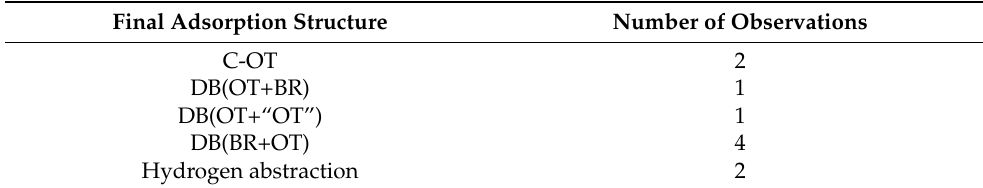
Table 3. Final configuration of ECCO in the 10 AIMD runs. The intermediate step to a DB(OT+OT) structure is labeled DB(OT+“OT”). Hydrogen abstraction indicates a structure in which hydrogen in the α position to the cyclooctyne triple bond was transferred to an Si up